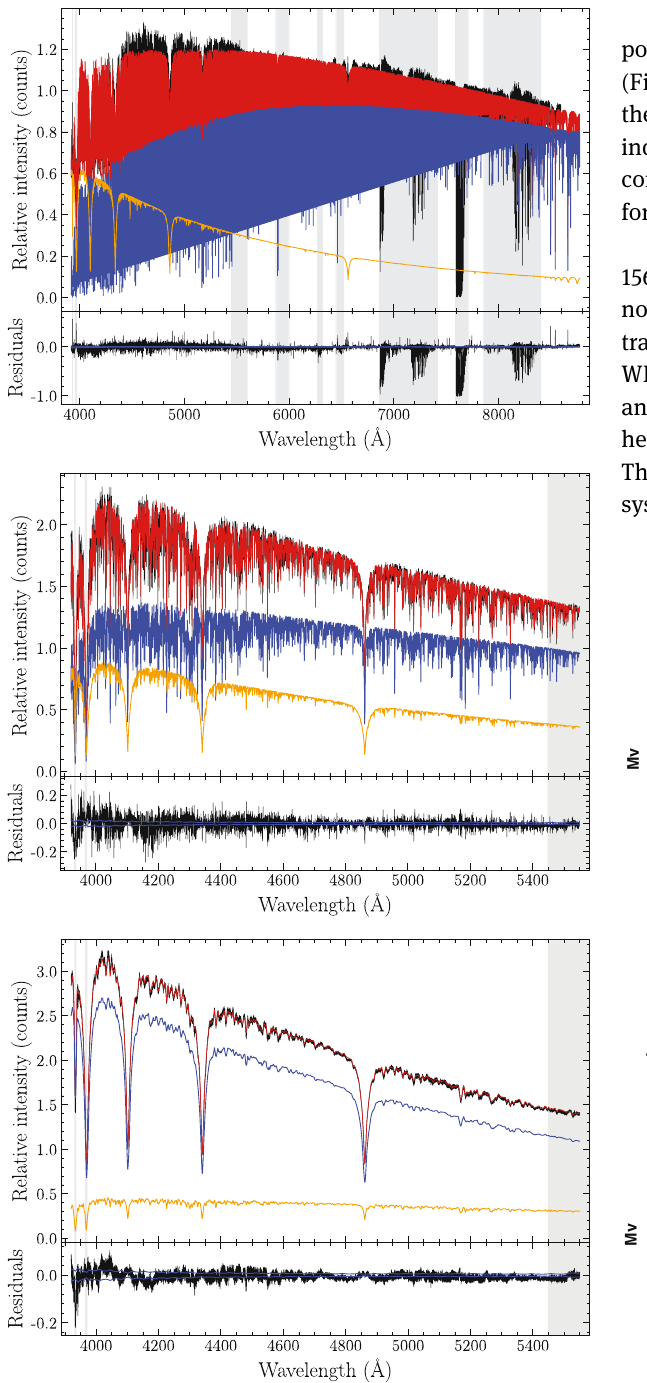
Figure 1: The results of the fbs fi t all stars in this work: HD 101379 ( top ) , HD 156331 ( middle ) , and HD 160928 ( bottom ) . Each panel consists of two sub - panels: the top one shows the result of the fi t in the spectral range 3,900 – 8,870 Å . The observed spectrum is shown in black. Both found components are shown in blue and orange, respectively, with their sum showninred.Thebottomoneshowsthedi ff erencebetweentheobserved spectrum and its model in black, altogether with errors propagated from the HRS data reduction ( continuous dark blue line ) . Gray vertical areas mark the spectral ranges that were excluded from the fi t for di ff erent reasons, mainly due to bands of lines from the Earth atmosphere. Only blue spectra for HD 156331 and HD 160928 are shown for more details.